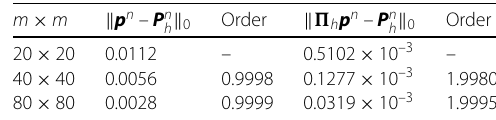
Table 6 Numerical results at t = 0.5 with τ = 5 h